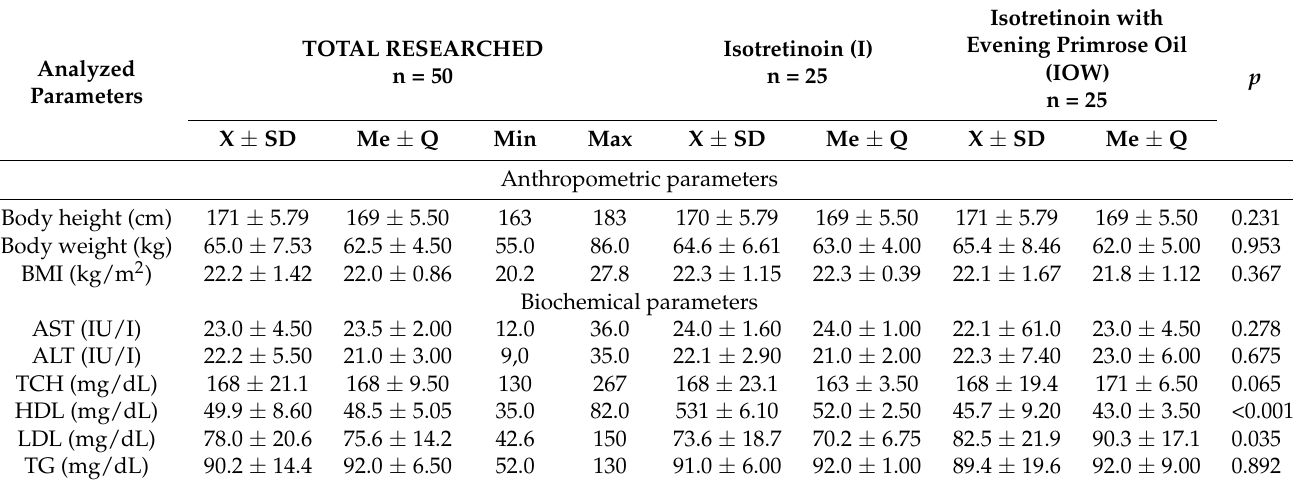
Table 2. Baseline characteristics of the study